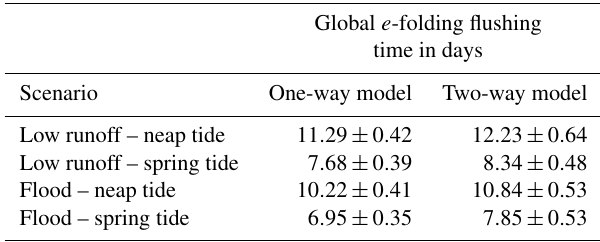
Table 5. Global e -folding flushing times and standard deviation in days for the whole control volume for both modeled configurations. The deviation is estimated over the 13 time-released simulations for each